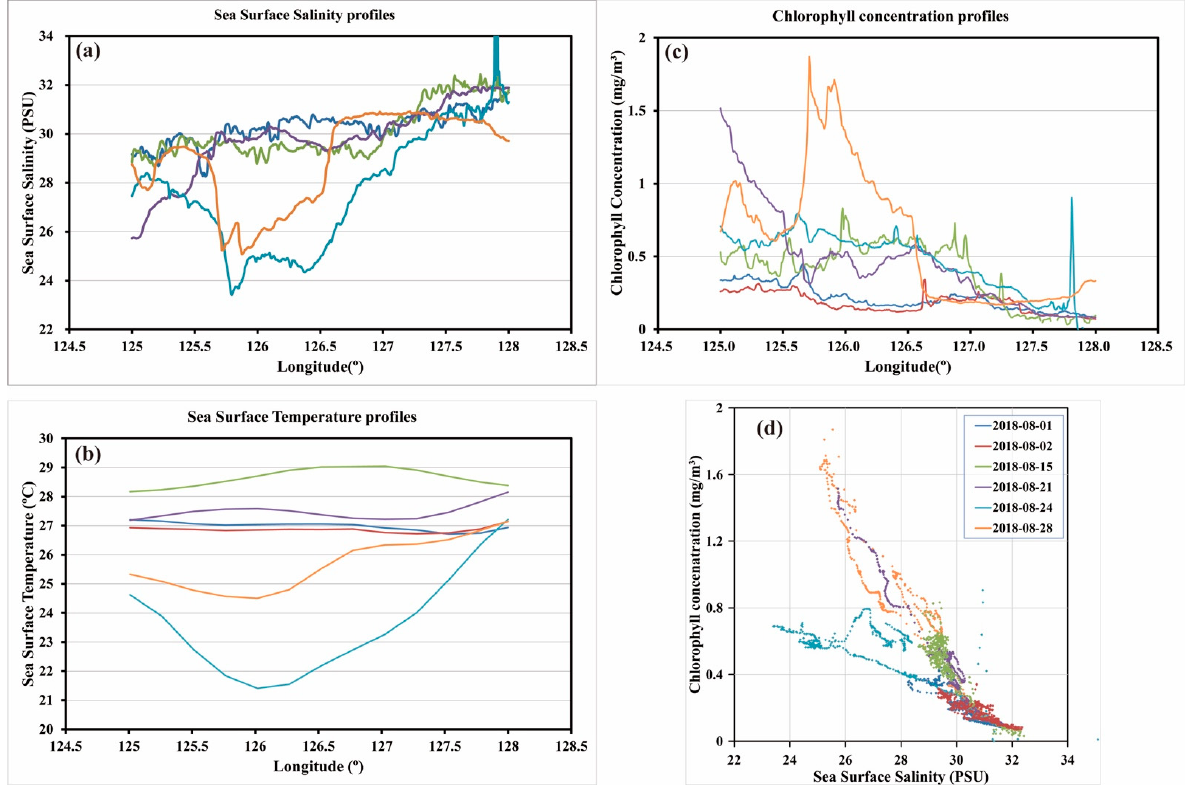
Figure 9. Daily SSS values along line AA’ in Figure 7 on 1, 2, 15, 21, 24, and 28 August 2018 ( a ) with ( b ) the corresponding SST values from NOAA OISST SST images and ( c ) GOCI-derived daily CHL values. ( d ) the color-coded scatter plots of SSS from ( a ) against CHL in( c ).